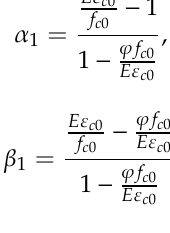
Figure 4. Determination of σ p 0 based on uniaxial tests.